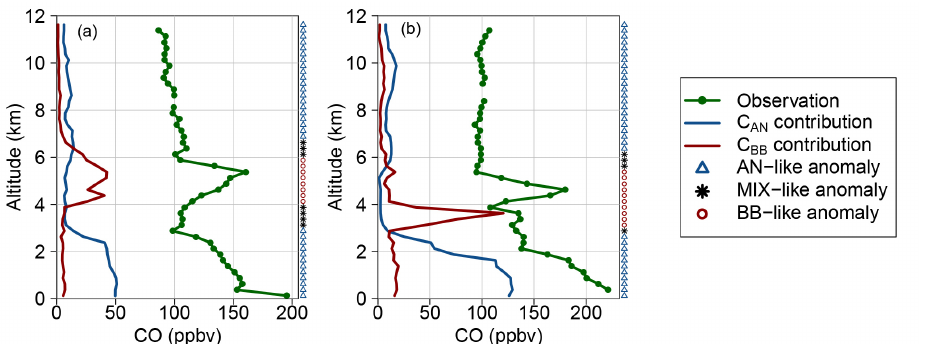
Figure 12. Vertical profiles of CO at New York airports on 28 (a) and 30 (b) August 2004. Observed CO mixing ratios are green; C BB and C AN contributions simulated with SOFT-IO are in red and blue, respectively. The class assigned to the observed anomalies based on the C BB / C AN ratio (see text) is indicated on the right side of each plot (AN-like anomalies with blue triangles, MIX-like anomalies with black stars and BB-like anomalies with red